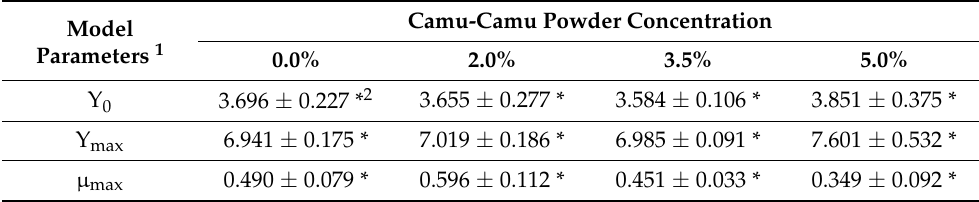
Table 3. Kinetic parameters of the Huang growth model describing lactic acid bacteria concentrations in vacuum-packed ground beef containing different camu-camu powder levels stored at 5 ◦ C.